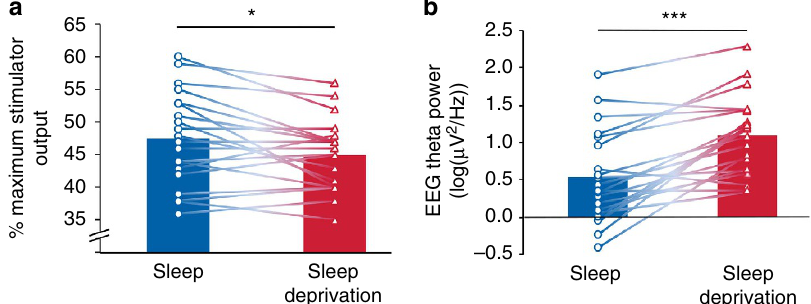
Figure 1 | Indices of cortical excitability/net synaptic strength. ( a ) Stimulation intensity of transcranial magnetic stimulation (% maximum stimulator output) was significantly lower after sleep deprivation compared with sleep. ( b ) Theta activity of wake electroencephalography (EEG) was significantly higher after the sleep deprivation compared with the sleep condition. Bars represent means ( n ¼ 20). Individual data lines visualize the change between the two conditions at the single-subject level. Paired-sample t -tests were used (two-tailed): * P o 0.05, *** P o